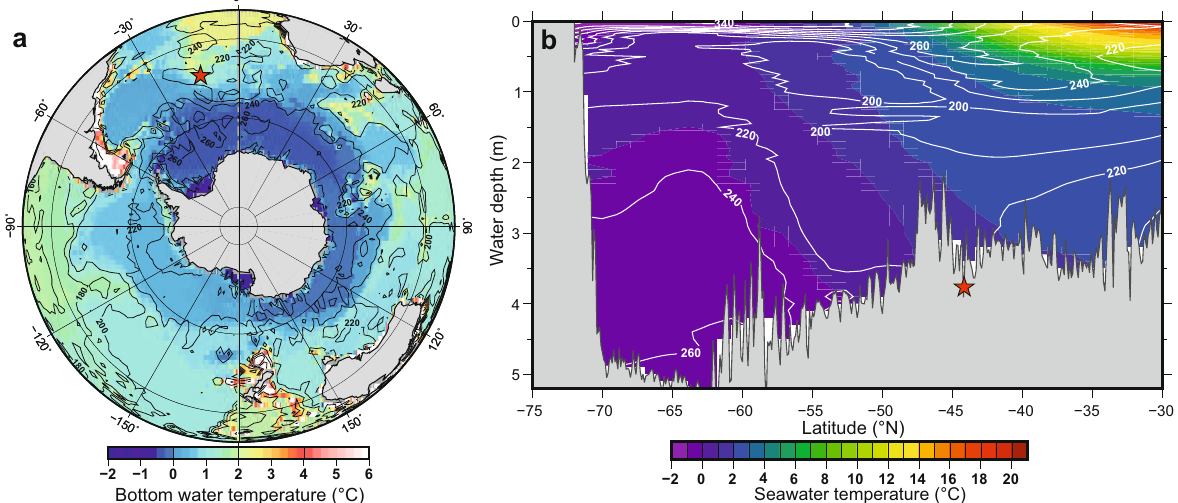
Fig. 1 Location and hydrography of the study site. Location of core MD07-3076Q (red star) is shown with the modern ocean temperature (shading) 49 , and dissolved O 2 concentration (contours) 50 ; a shown as deep-water temperature T dw (at greatest depth) in a stereographic projection of the Southern Ocean, and b in a meridional transect of the South Atlantic along 14°